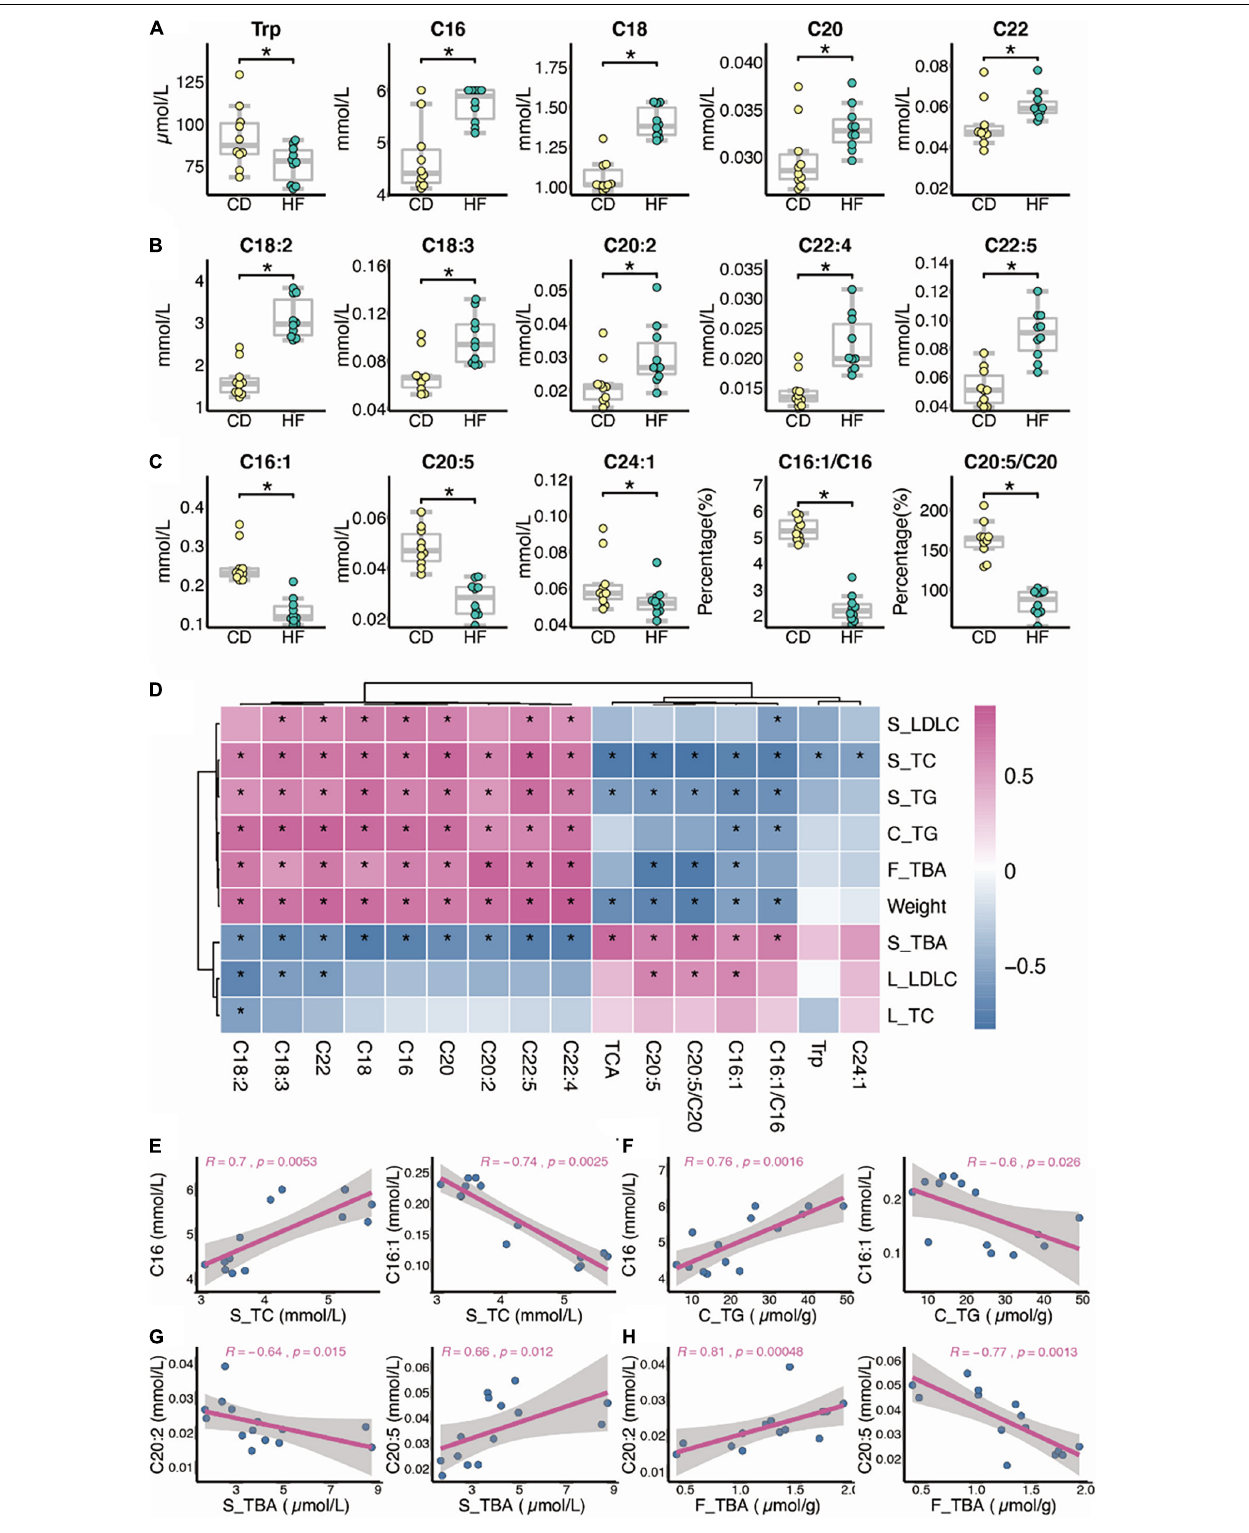
FIGURE 2 | Dysbiosis of serum metabolic patterns in HF feeding mice. (A–C) Differential metabolites between CD and HF groups ( n = 10). (D–H) Spearman correlation between changed metabolites and biochemical indexes ( n = 7; S, serum; L, liver; C, colon; F, feces). The two-tailed Wilcox test was used to determine the significant difference in CD and HF groups. * p < 0.05. CD, control diet group; HF, high-fat diet group.